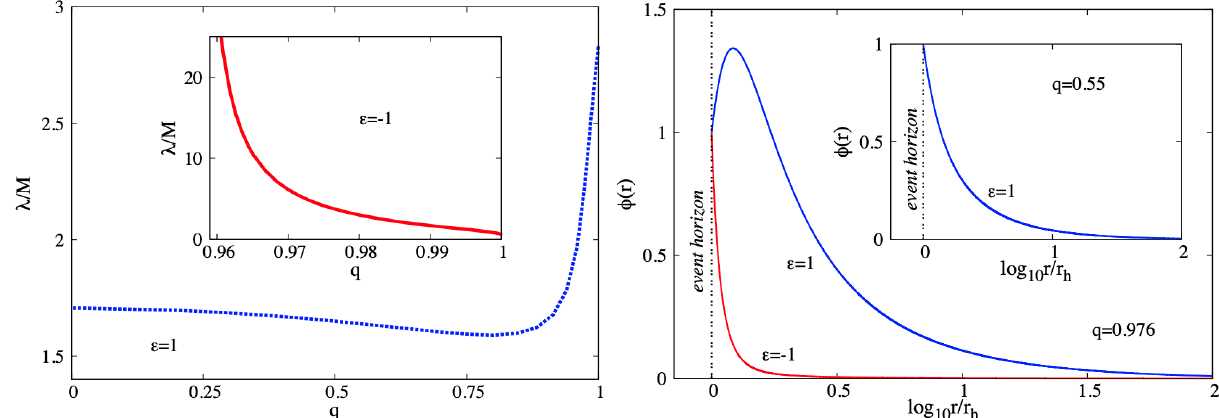
Figure 2. ( Left panel ) Dimensionless ratio λ / M of the set of RN solutions supporting the (cid:96) = m = n = 0 scalar cloud vs. the reduced electric charge q for (cid:101) = ± 1. ( Right panel ) Typical radial profiles of the spherical, nodeless scalar clouds on a RN BH